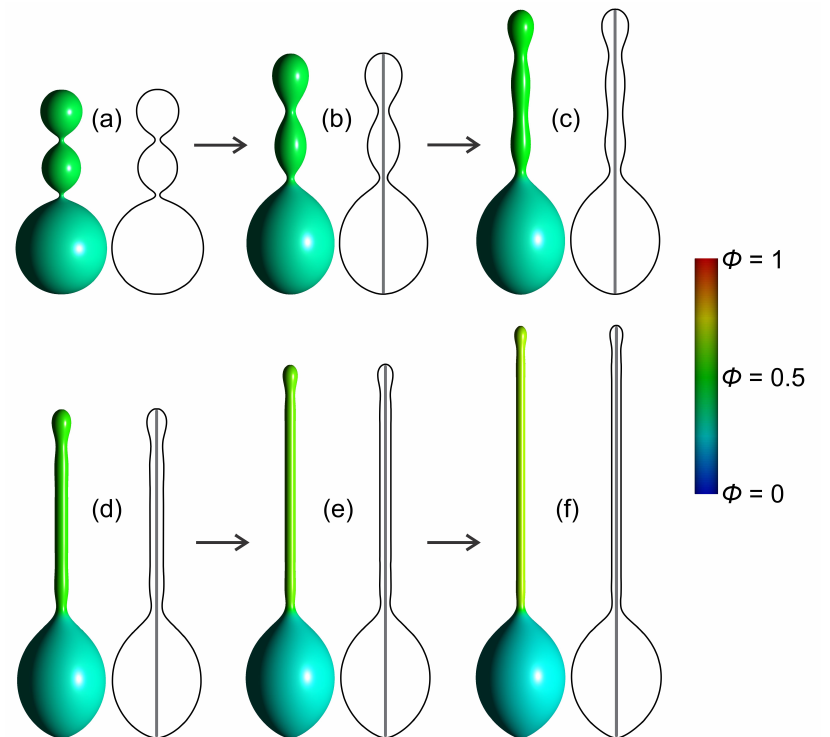
Figure 23. Equilibrium closed membrane shapes calculated for different lengths of the cytoskeleton rod-like structure inside the membrane (schematically shown as a grey rod inside the profile curve for each shape). Membrane contains two types of nanodomains denoted by A and B . Fixed value of average relative area density is φ ave = 0.35 for the nanodomains A and ( 1 − φ ave ) for the nanodomains B . The red color ( φ = 1) represents the highest possible local relative area density (concentration) of curved nanodomains A , while the local concentration of flat nanodomains B is given by ( 1 − φ ) . For simplicity reasons, the entropy of mixing of different membrane nanodomains was not taken into account. Shapes were calculated within the model introduced in Section 2.7 for the following values of model parameters: v = 0.70, H B m = 0, D B m = 0, H A m = 12, D A m = 0, κ A = κ B